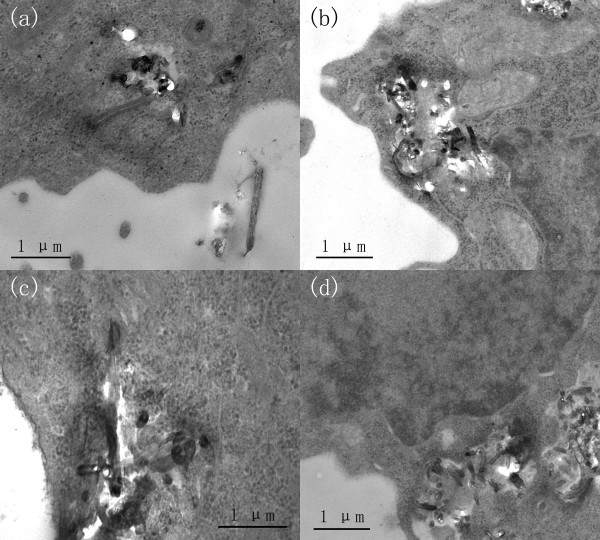
TEM photographs show the cellular uptake of MWCNTs. Cells were incubated overnight in media containing 50-μg/mL S- (a and b) and L-MWCNTs (c and d), and MWCNTs internalisation in MCF-7 (a and c) and RAW264.7 cells (b and d) were analysed by TEM as described in the ‘Methods’ section.